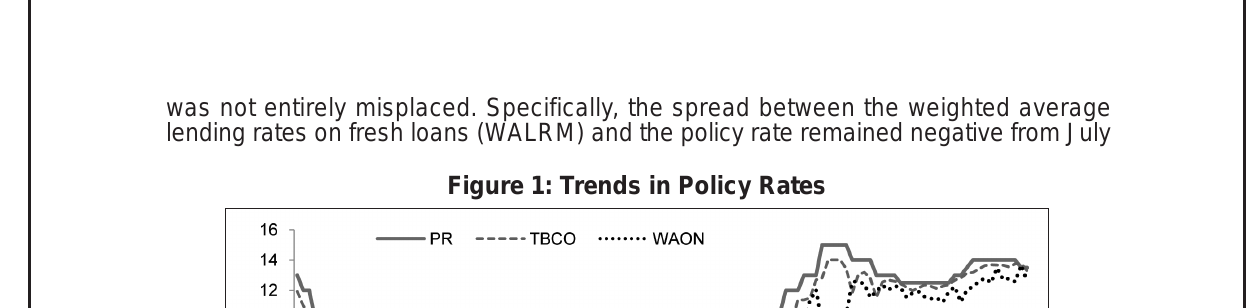
Figure 1: Trends in Policy Rates